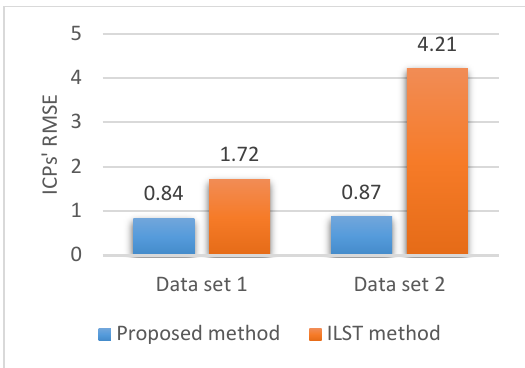
Figure 2. ICPs’ RMSE of both data sets